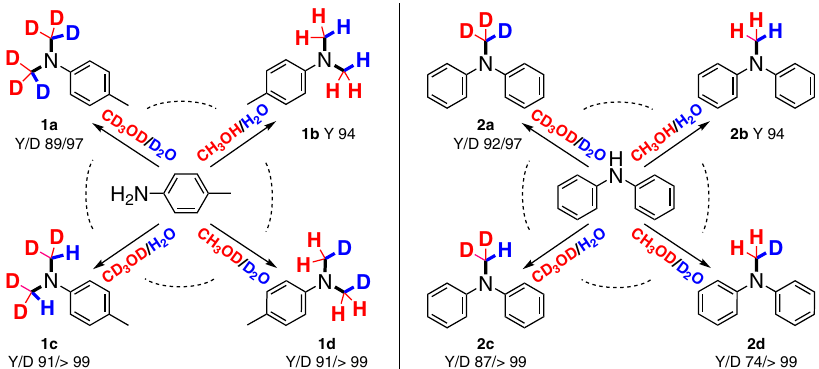
Fig. 2 Controllable D-labeled N -methylation of primary and secondary amines. Y refers to isolated yields of deuterated products. D refers to D- incorporation percentages based on the calculation of 1